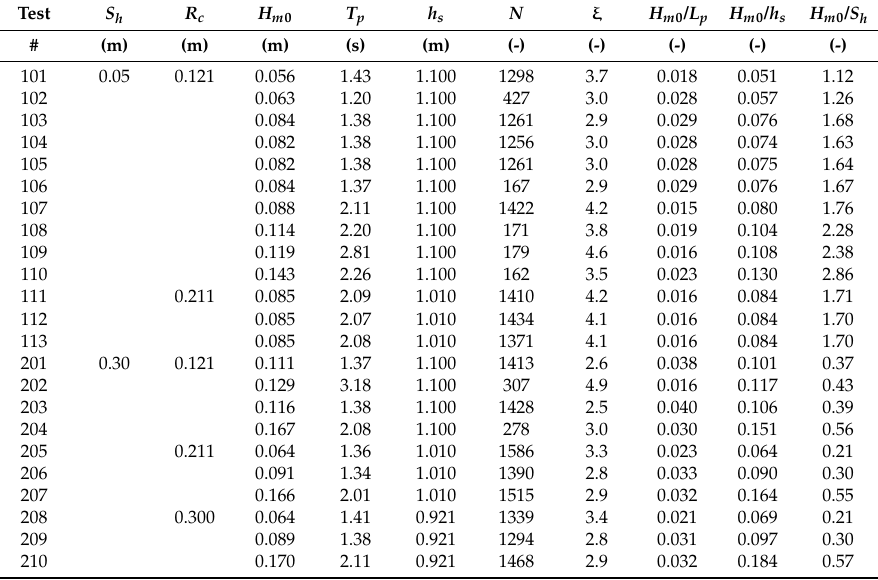
Table 1. Hydraulic boundary conditions for the wave impact tests.